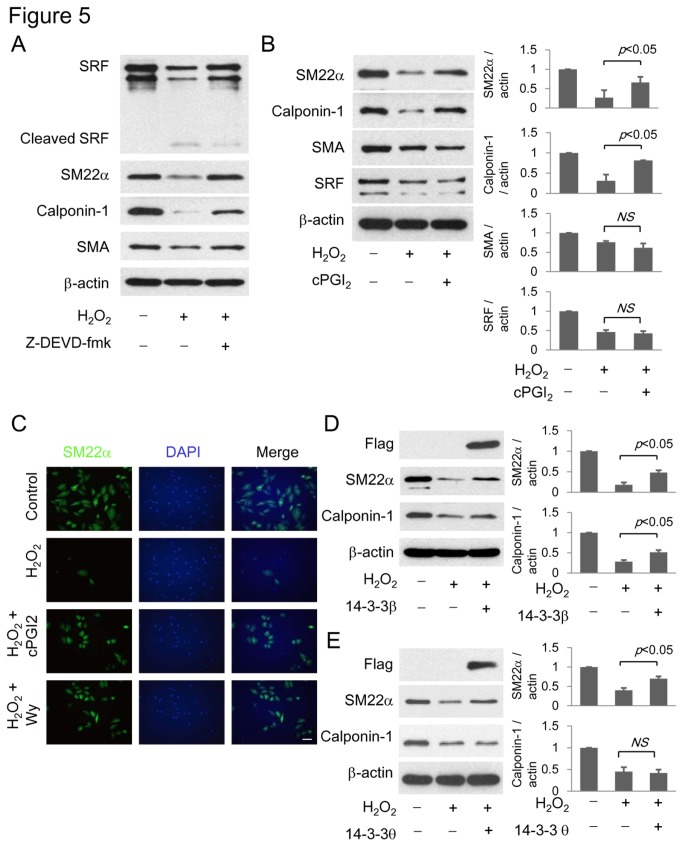
H2O2 degrades VSMC contractile proteins and SRF via caspase 3.(A) Cells were pretreated with Z-DEVD-fmk (20 µM) followed by H2O2. SRF and contractile proteins were analyzed by Western blotting. (B) Cells were pretreated with cPGI2 (100 µM) followed by H2O2. SRF and contractile proteins were analyzed by Western blotting. (C) Immunofluorescent staining of SM22α and nuclear staining with DAPI in H2O2-treated cells in the absence and the presence of cPGI2 or Wy14,643. Scale bar = 100 µm. (D) VSMCs were transfected with Flag-tagged 14-3-3β or θ vectors. Following H2O2 treatment, cells were lysed and SM22α and calponin-1 were determined by Western blotting. Each error bar denotes mean±SEM and all blots are representative of n≥3.